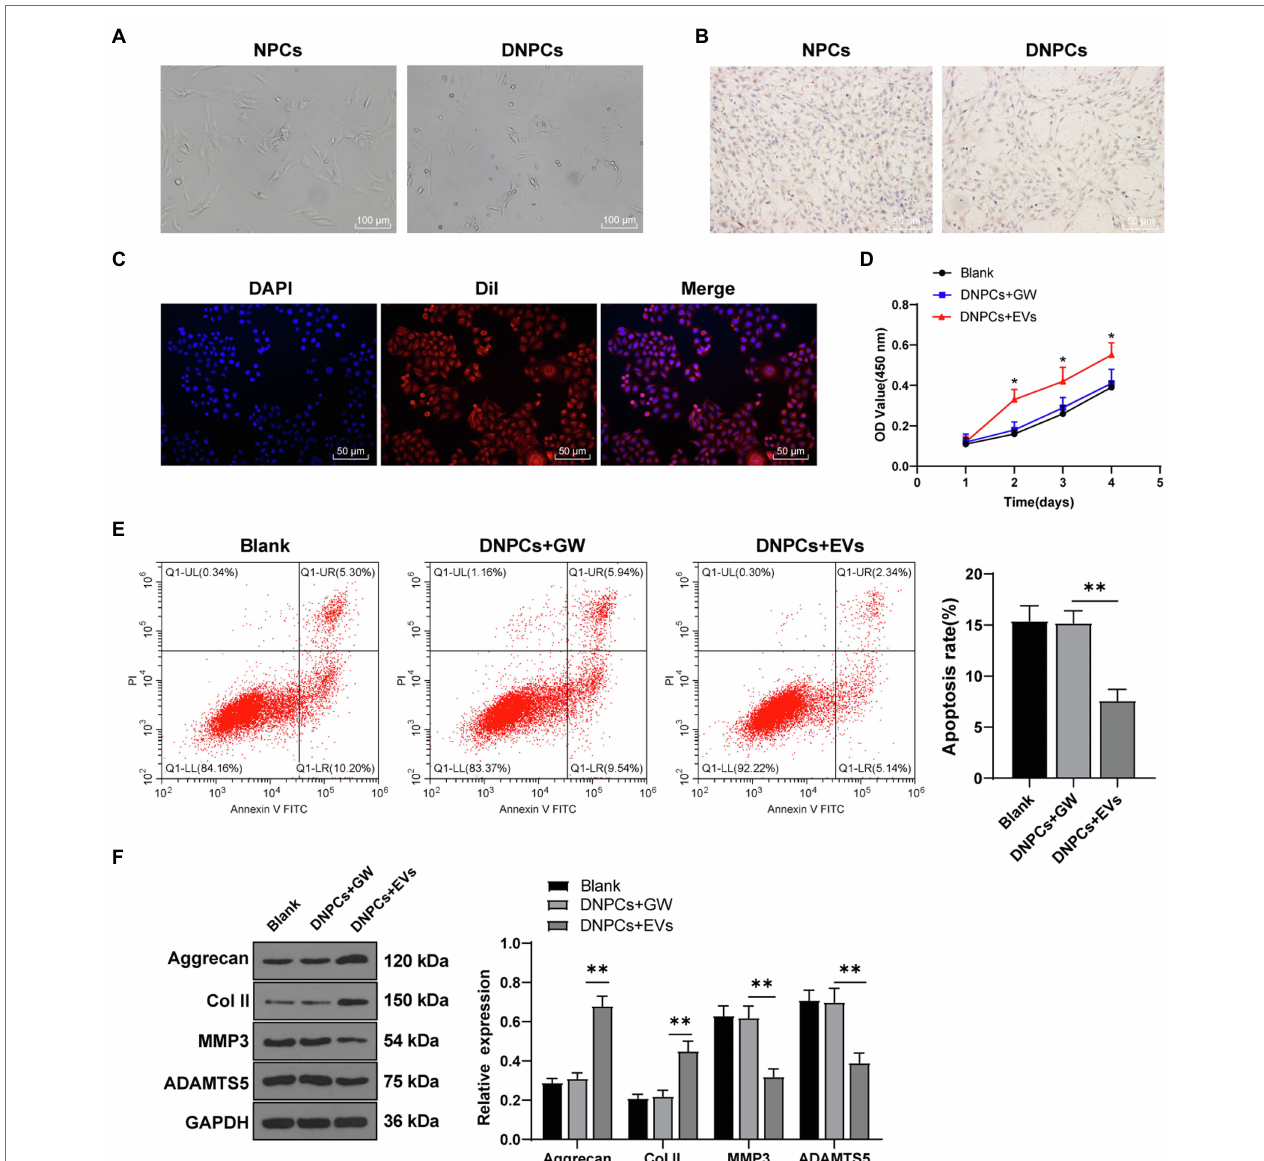
FIGURE 2 | hBMSC-EVs promoted degenerated nucleus pulposus cells (DNPCs) proliferation and extracellular matrix (ECM) synthesis. DNPCs were induced by tumor necrosis factor- α (TNF- α ). (A) morphology of NPCs and DNPCs observed under a microscope; (B) expression of Col II detected by immunofluorescence; (C) internalization of Dil-labeled EVs by DNPCs detected by immunofluorescence after incubating EVs with DNPCs for 24 h; (D) DNPCs proliferation detected by CCK-8 assay; (E) DNPCs apoptosis detected by flow cytometry; (F) expressions of ECM synthetic genes Aggrecan and Col II and ECM degrading genes MMP3 and ADAMTS5 detected by Western blot. Cell experiment was repeated three times. Data were presented as mean ± standard error. Comparisons among groups were analyzed using one-way ANOVA, followed by Tukey’s multiple comparisons test. * p < 0.05, ** p <